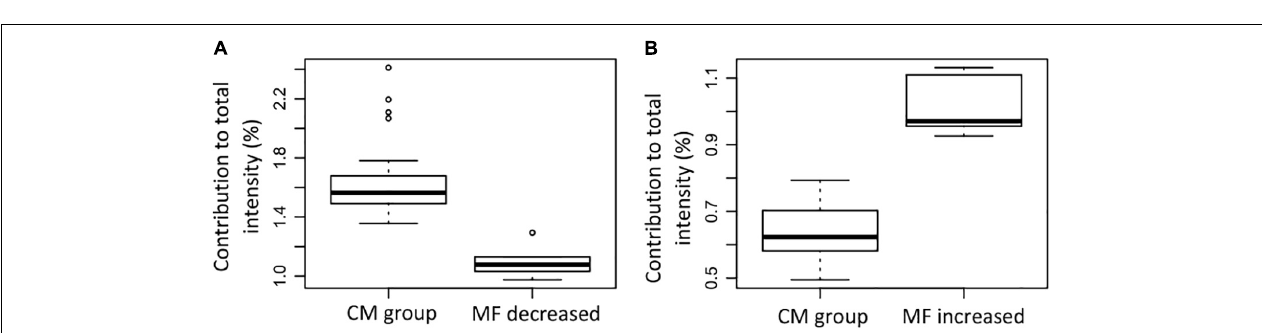
FIGURE 7 | Comparison of environmental parameters between the group of samples that lost SPE-DOC ( n = 6) and the group of samples that gained SPE-DOC ( n = 6). The environmental parameters depicted are water depth (A) , dissolved oxygen (B) , chlorophyll-a (C) , nitrate (D) , N:P ratio (E) , silicate (F) , and phosphate (G) .